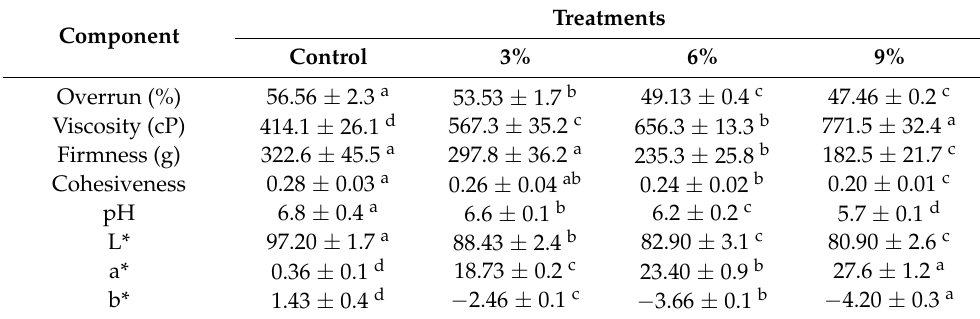
Table 3. Physicochemical properties of probiotic ice creams supplemented with